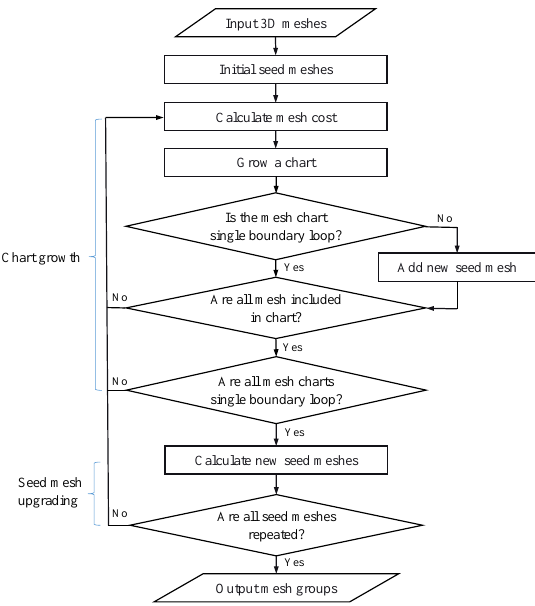
Figure 2. Flowchart of mesh partitioning.